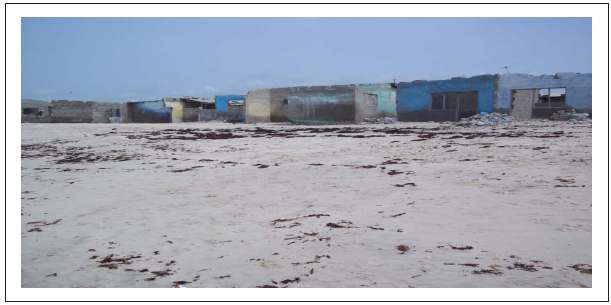
FIGURE 2: Severe erosion experienced on the eastern portion of Glefe